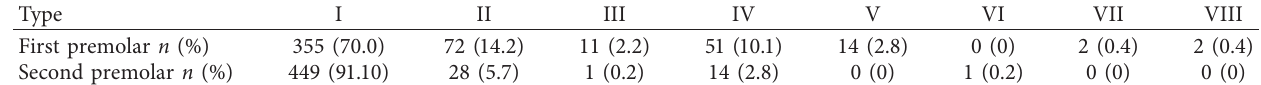
Table 3: Distribution of root canal types according to Vertucci’s